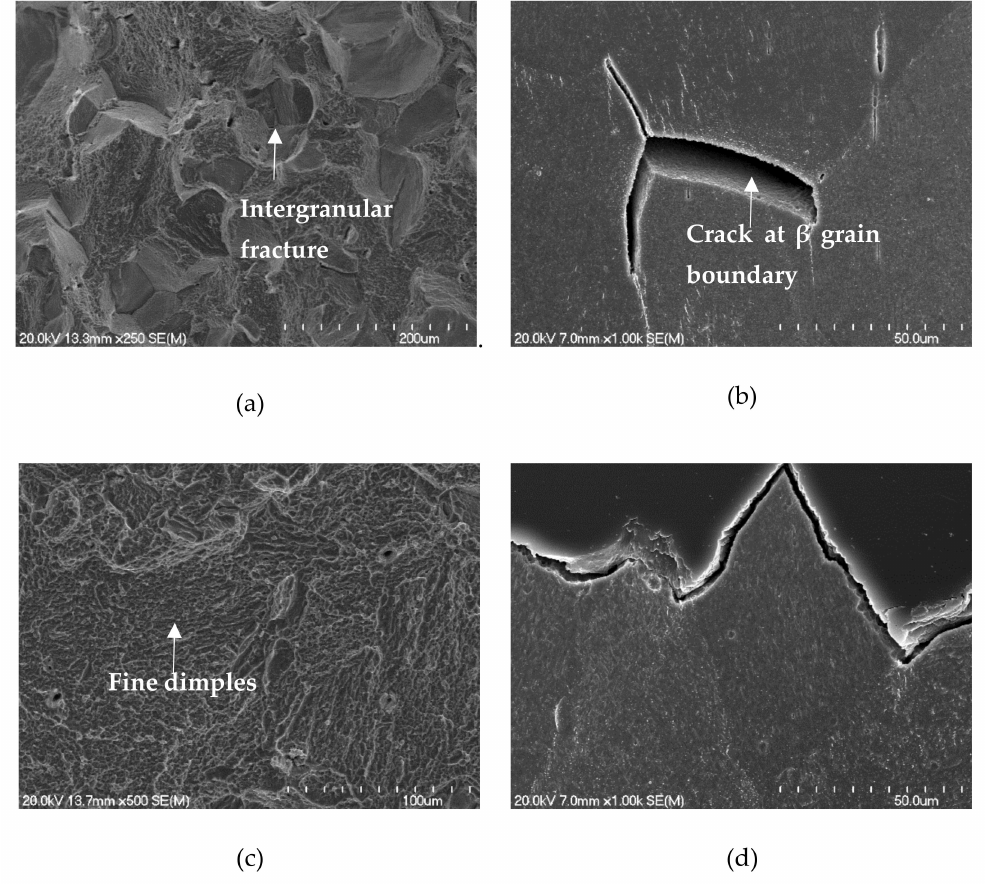
Figure 6. Fracture surfaces ( a , c ) and cross-sections ( b , d ) of the heat-treated PM Ti-5Fe alloys extruded at 800 ◦ C after tensile failure: ( a , b ) STA-550 and ( c , d )